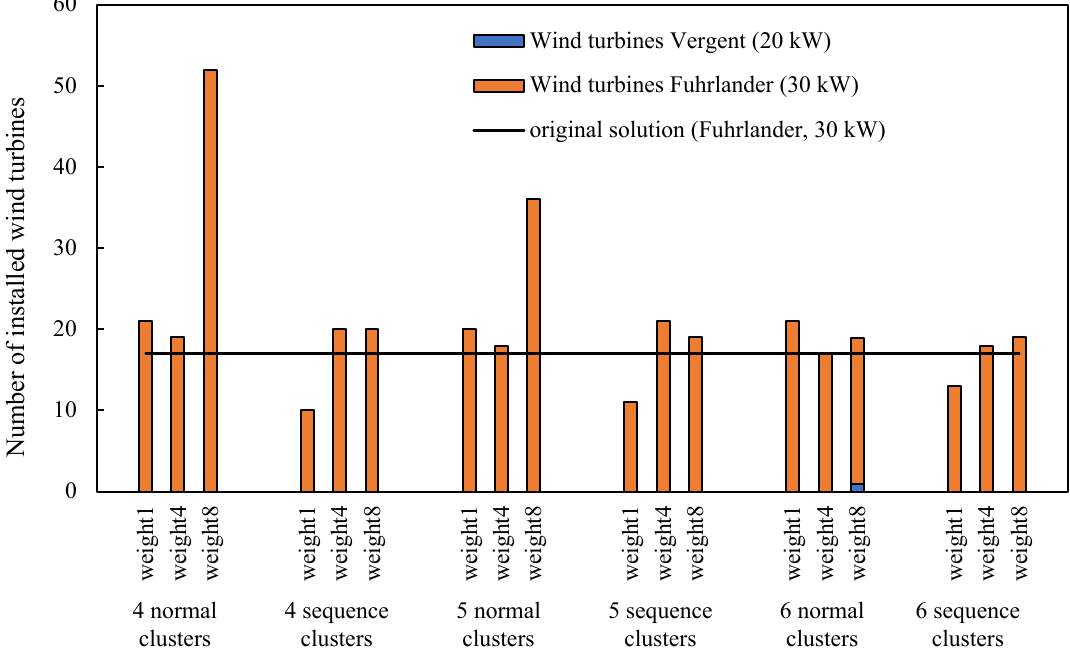
Figure 12. Number of wind turbines suggested by the original and clustered models under the GHG emissions constraint.